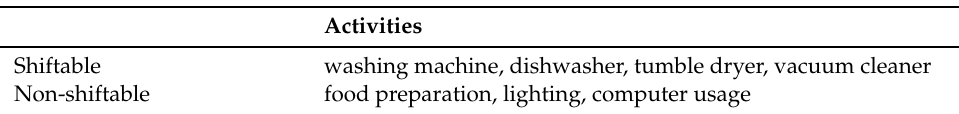
Table 4. Shiftable and non-shiftable activities identified by the